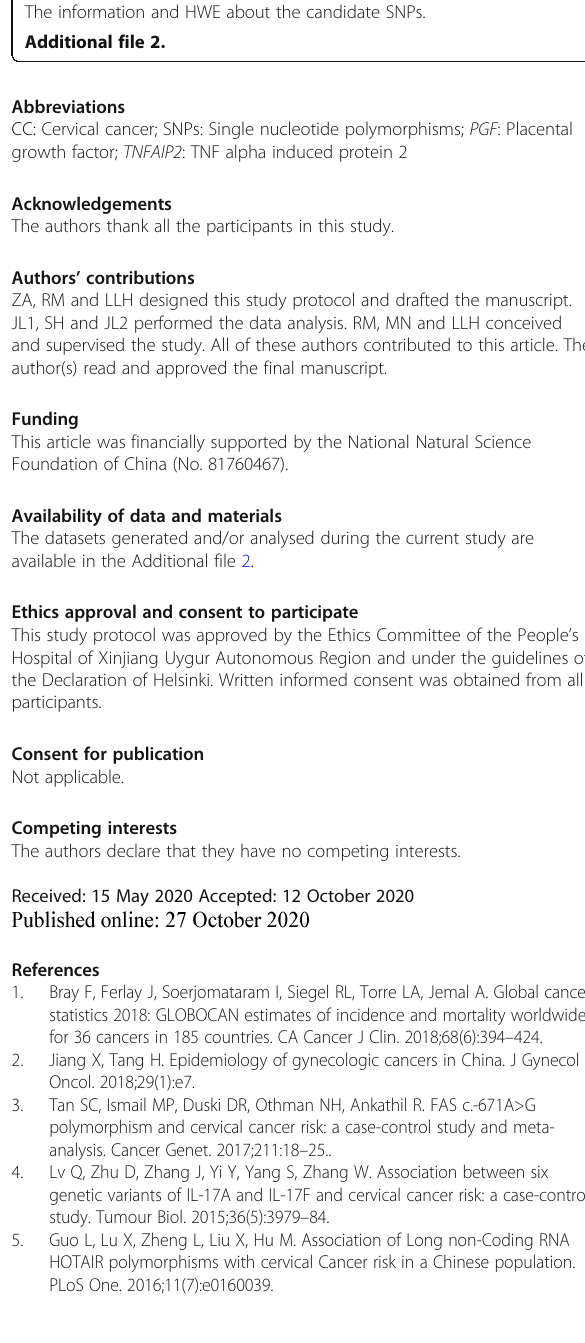
Additional file 1: Supplementary Table 1. Predicted stability, duplex formation, and functional effect of 3 ′ -UTR polymorphisms in miRNA- binding sites of selected genes. Supplementary Table 2. Primers se- quence of PCR and UEP used in this study. Supplementary Table 3. The information and HWE about the candidate